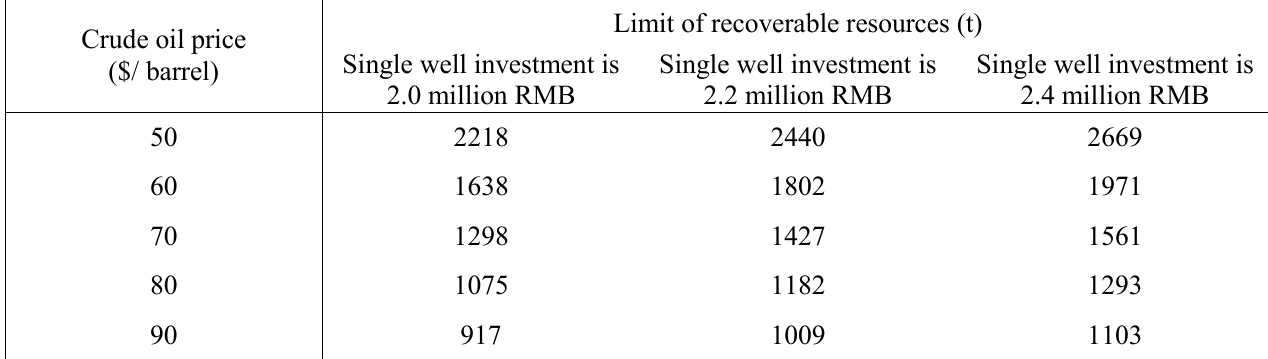
Table 1—The limit of recoverable resources under different single well investment.